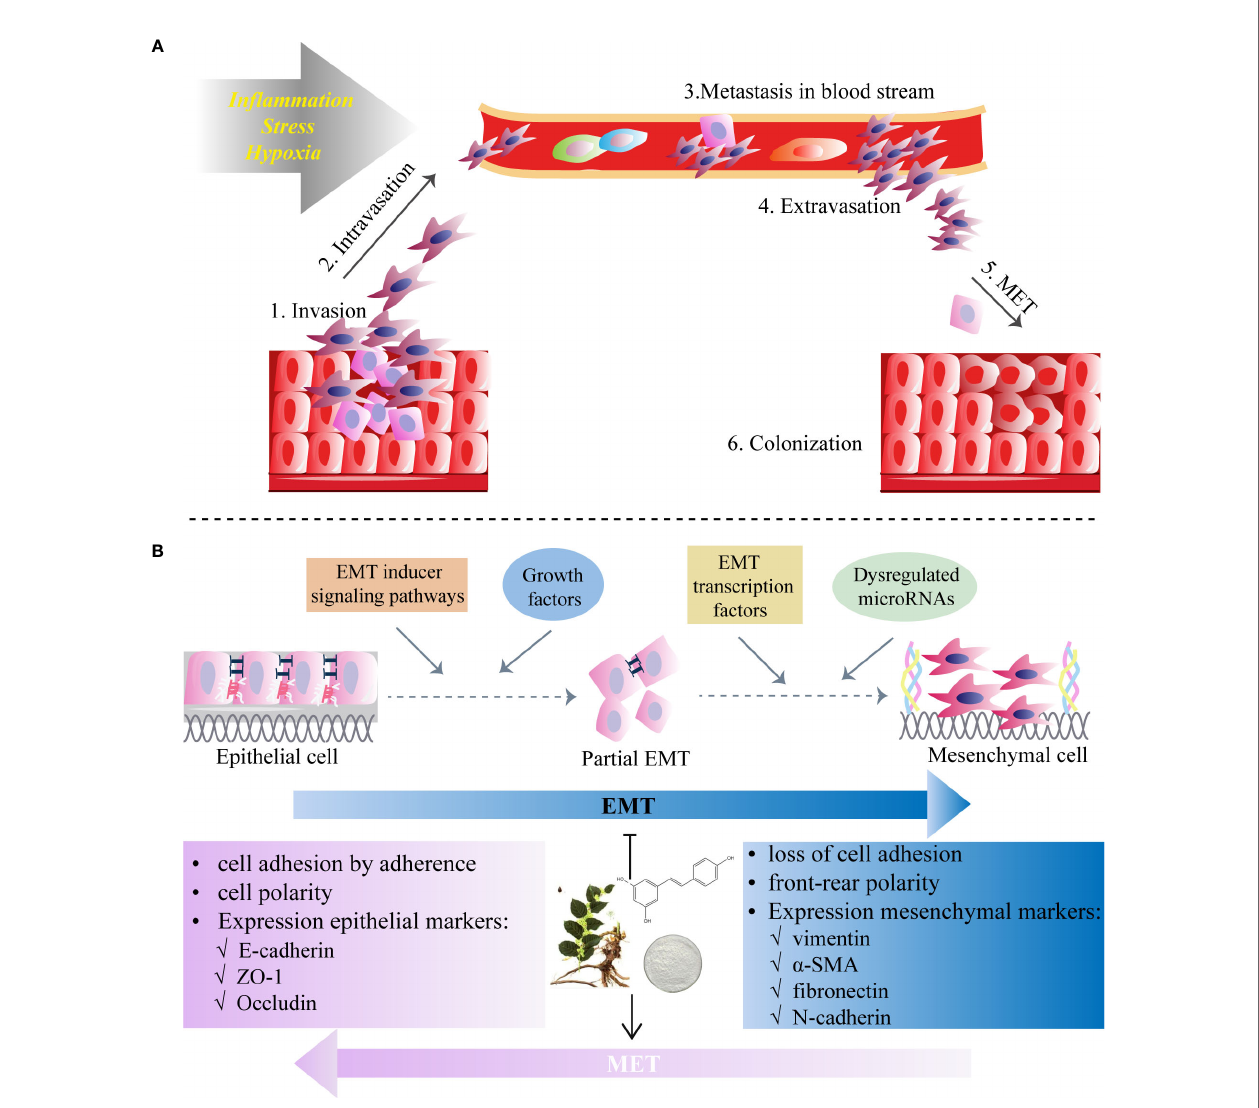
FIGURE 1 | Epithelial-to-mesenchymal transition (EMT) programme in cancers and the inhibitory role of RES. (A) Invasion and migration initiated by the EMT process due to the factors (e.g., in fl ammation, stress and hypoxia) affect tumor microenvironment. (B) Resveratrol inhibits EMT which starts from diverse processes (EMT inducer signaling pathways, growth factors, dysregulation of microRNAs and EMT transcription factors) and by which polarized epithelial cells acquire motile mesothelial features. The EMT process is characterized by the loss of cell-cell contacts via downregulation of epithelial markers (i.e. E-cadherin in adherent junctions, zonula occludens-1 (ZO-1) in tight junctions and desmoplakin in desmosomes) and upregulation of mesenchymal markers (N-cadherin, vimentin, fi bronectin and a - smooth muscle actin ( a -SMA)). RES may also induce mesenchymal-to-epithelial transition (MET), a reversal of the EMT